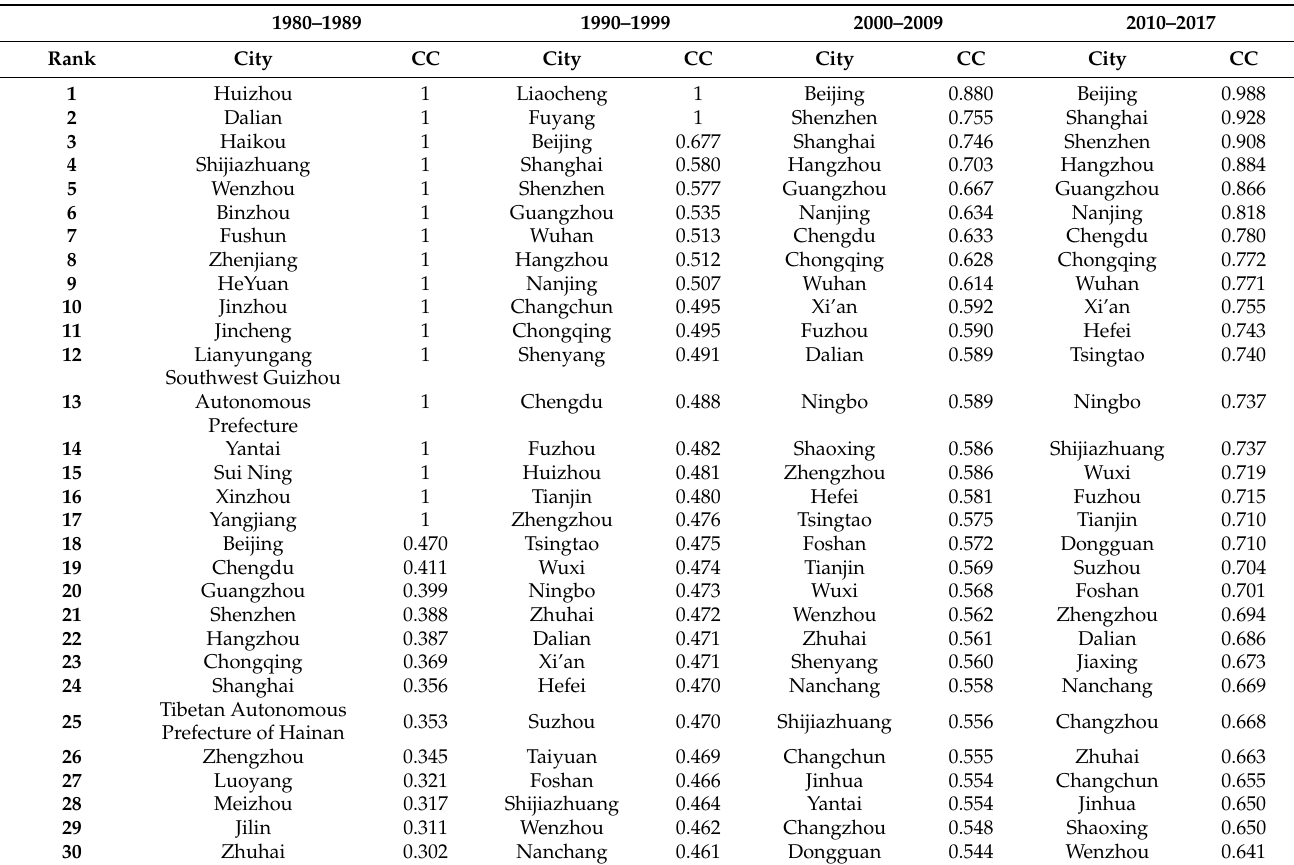
Table 4. Closeness centrality value of top 30